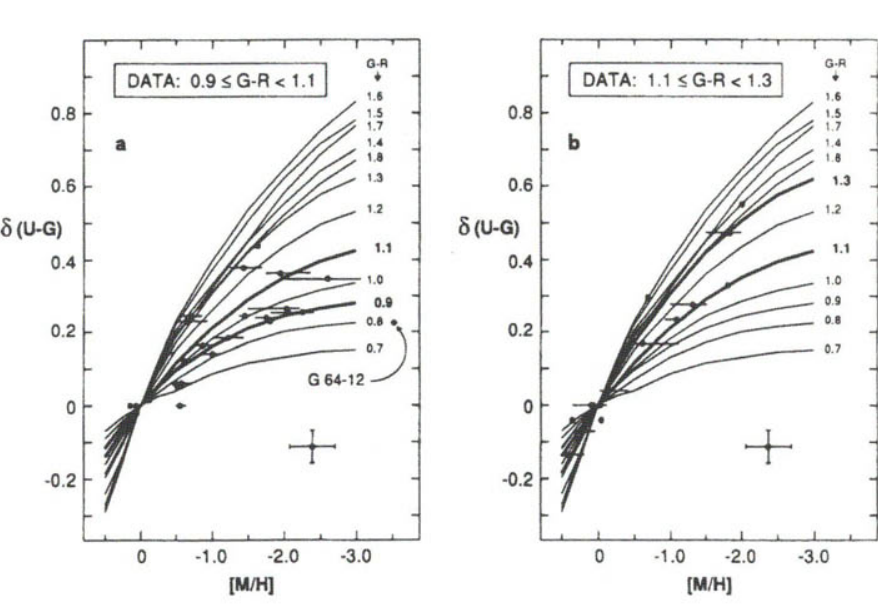
Fig. 5. (a) The metallicity parameter, U-G), as a function of metal- licity [M/H] and G-R color. The theoretical calibration (lines) is in good agreement with the results obtained from spectroscopic observations for stars with observed colors, 0.9 < G-R < 1.1, corresponding to 0.45 < B-V< 0.7, or spectral types F5 to G5 (Buser and Fenkart 1990). (b) The metallicity parameter, 8(U-G), as a function of metallicity [M/H] and G-R color. The theoretical calibration (lines) is again supported by results obtained from spectroscopic observations for stars with observed colors, 1.1 < G-R < 1.3, corresponding to 0.7 < B-V < 0.85, or spectral types G5 to K1 (Buser and Fenkart